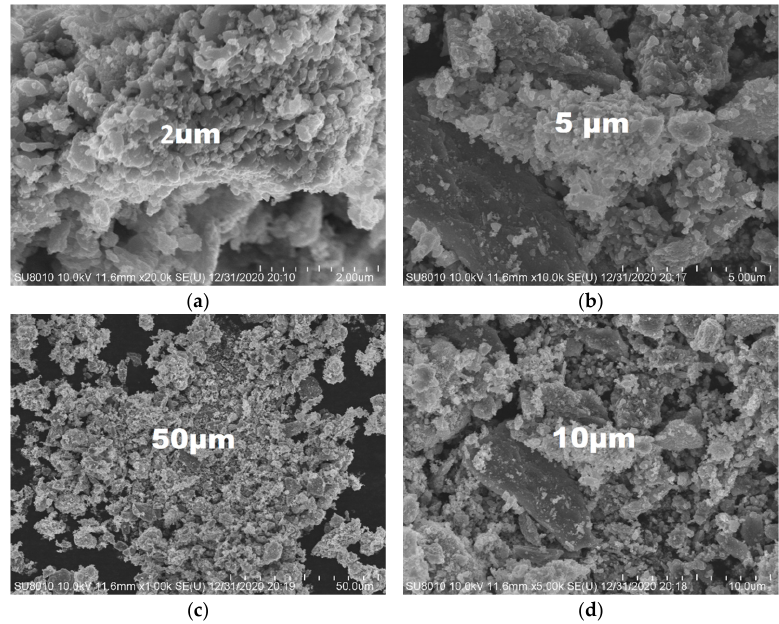
Figure 9. SEM micrographs of the (Fe,Co,Mn)Ox material. ( a ) Image acquired using a 10 kv accel- erating voltage at 20,000 × length of 2 µ m; ( b ) image acquired using a 10 kv accelerating voltage at 10,000 × length of 5 µ m; ( c ) image acquired using a 10 kv accelerating voltage at 1000 × length of 50 µ m and ( d ) image acquired a 10 kv accelerating voltage at 5000 × length of 10 µ